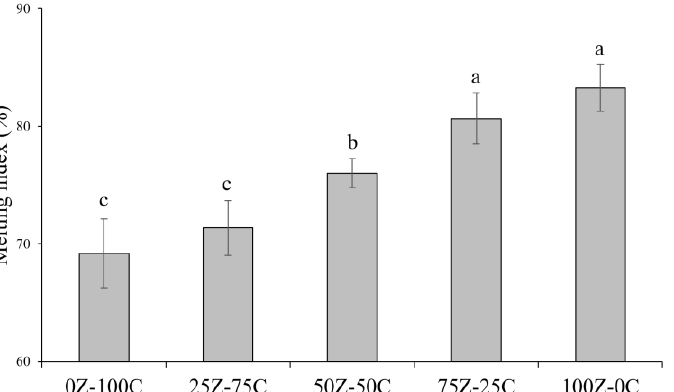
Figure 4. Meltability index of plant-based cheese alternative samples. Different letters (a–c) indicate significant differences between samples ( p < 0.05).